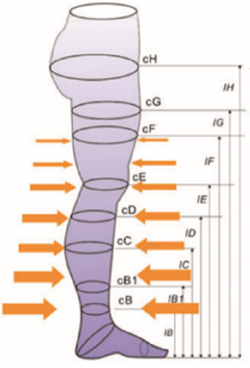
Figure 2. Measurement Points of the Stockings [24].